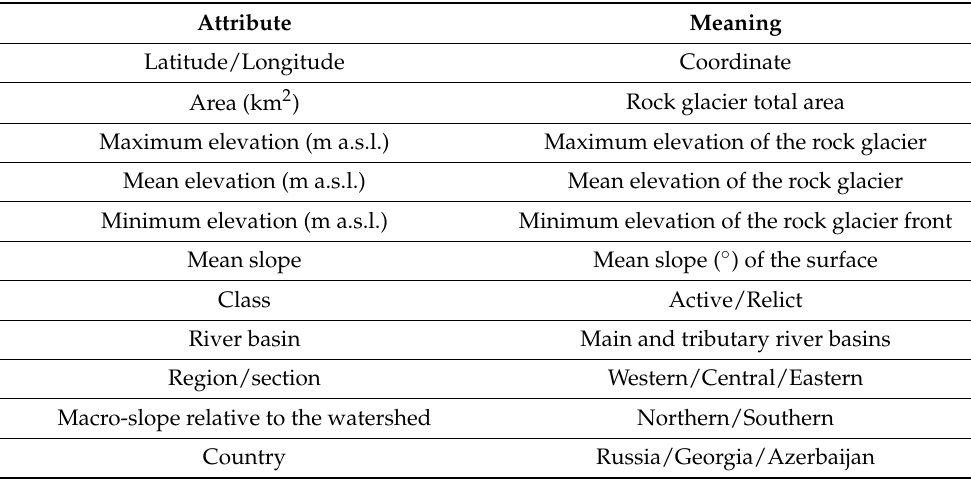
Table 1. Rock glacier attributes obtained during the